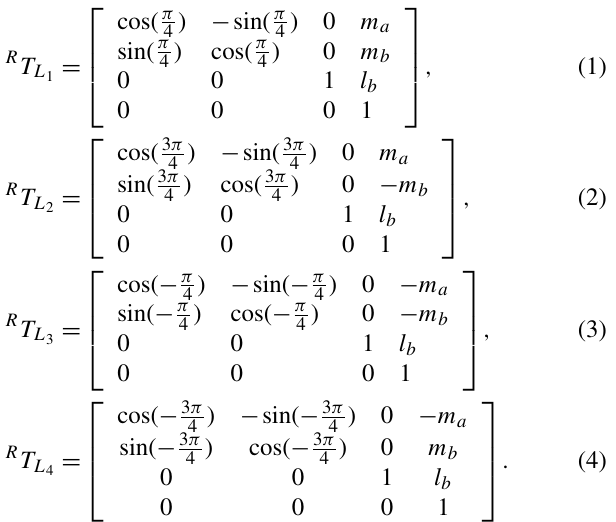
Figure 4. Wheel driven by two motors.